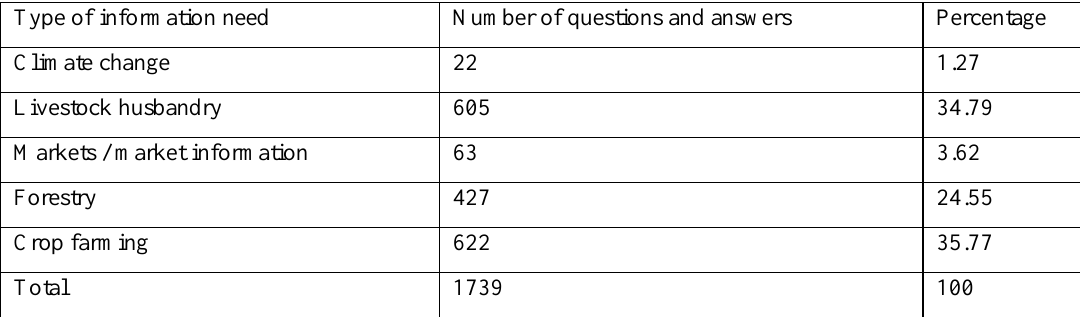
Figure 6 . General information needs and seeking behaviour of farmers using